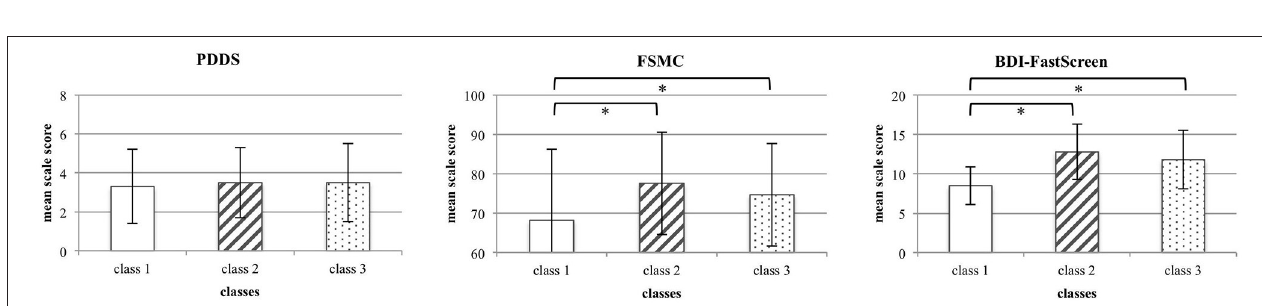
FIGURE 2 | Differences in maladaptive coping modes between the three classes. For each coping mode, mean item scores ( ± SD) are displayed. Asterisks highlight statistically significant differences across classes.